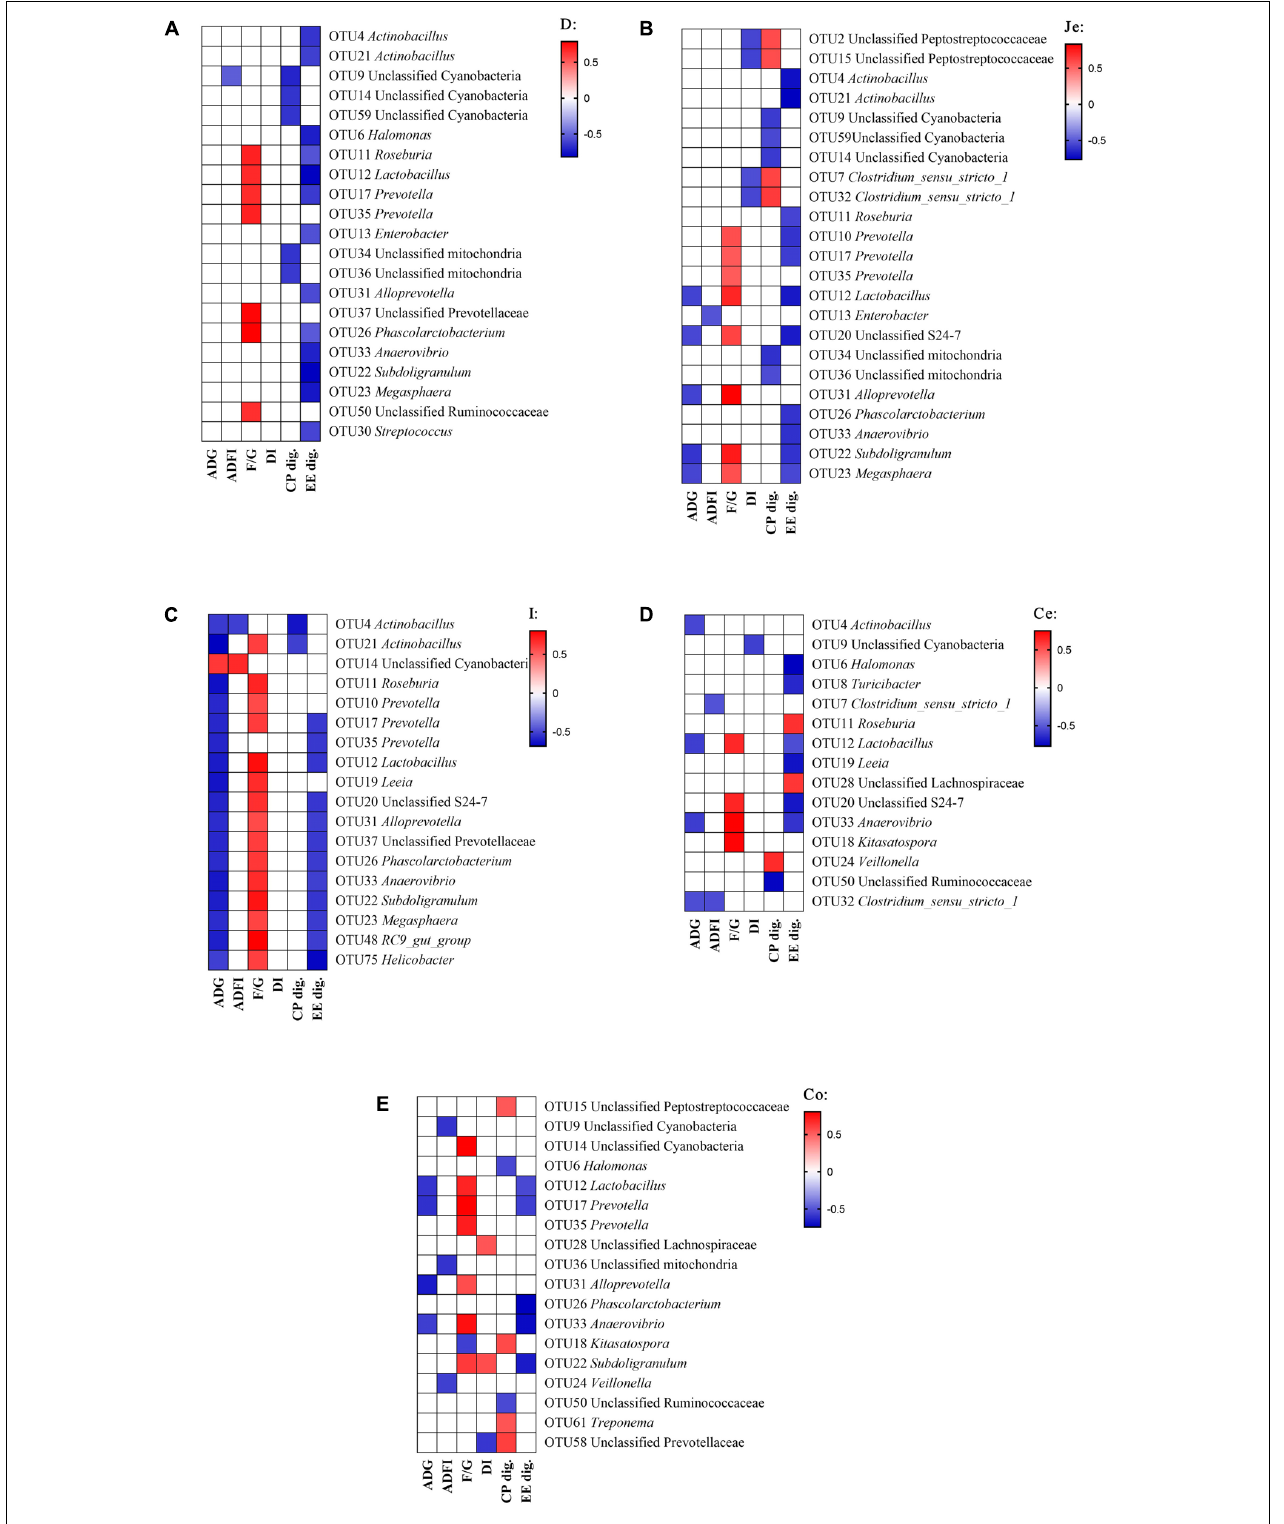
FIGURE 5 | Correlation analysis between the abundance of microbiota (genus) and phenotypic data in the gut. Correlation was considered significant when the absolute value of Pearson correlation coefficient was > 0.5 and P < 0.05. (A) duodenum, (B) jejunum, (C) ileum, (D) cecum, (E) colon; ADG, average daily gain; ADFI, average daily feed intake; F/G, Feed conversion ratio; DI, diarrhea incidence; CP dig., crude protein digestibility; EE dig., crude fat digestibility.